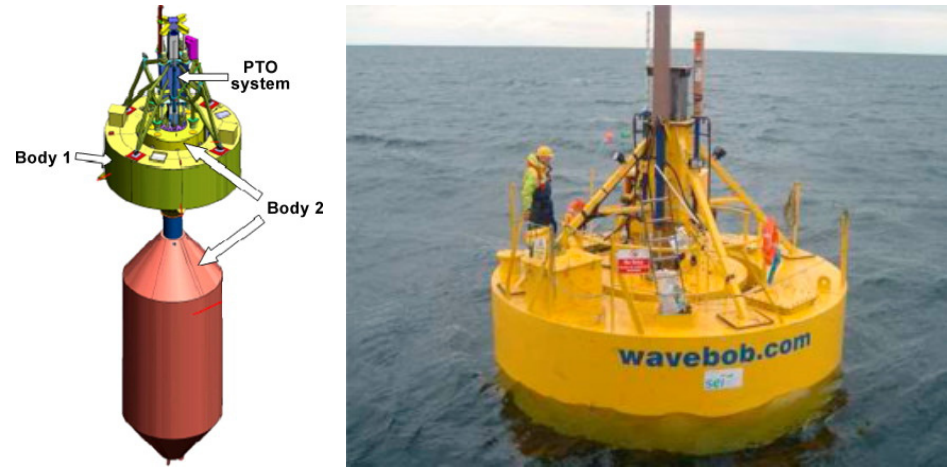
Figure 19. Rendering view ( left ) (Reproduced with permission 5139260046167 from [32], Elsevier, 2010) and external view ( right ) of Wavebob (Reproduced with permission 5139260268553 from [72], Elsevier, 2016).